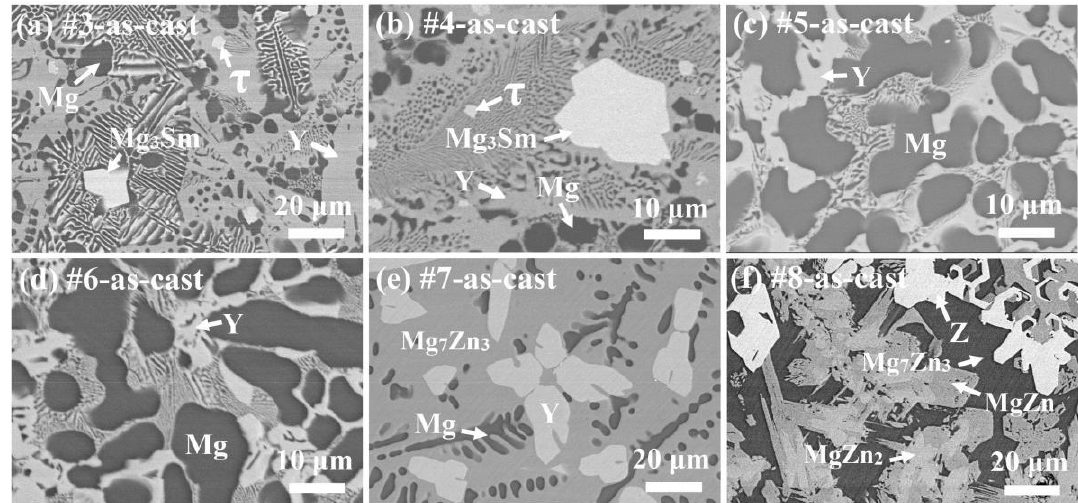
Figure 2. The BSE images of as-cast alloys #3 – #8 ( a – f ) .